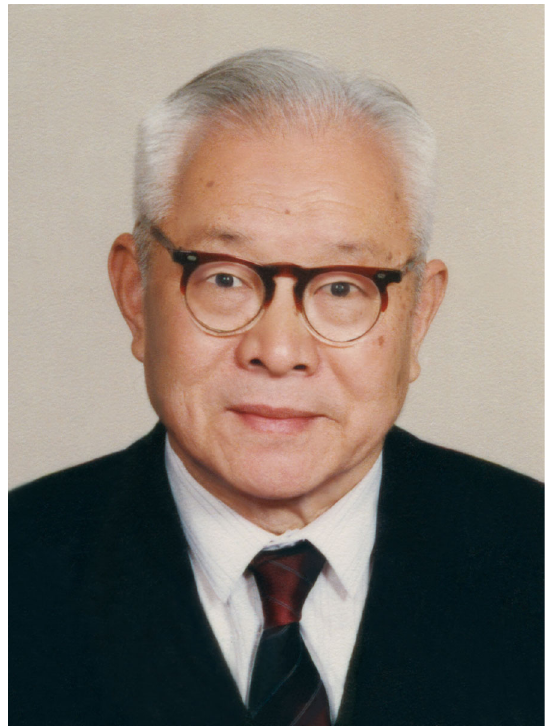
Figure 1. Dr. Chi-Ming Chu (1917.9.12 –